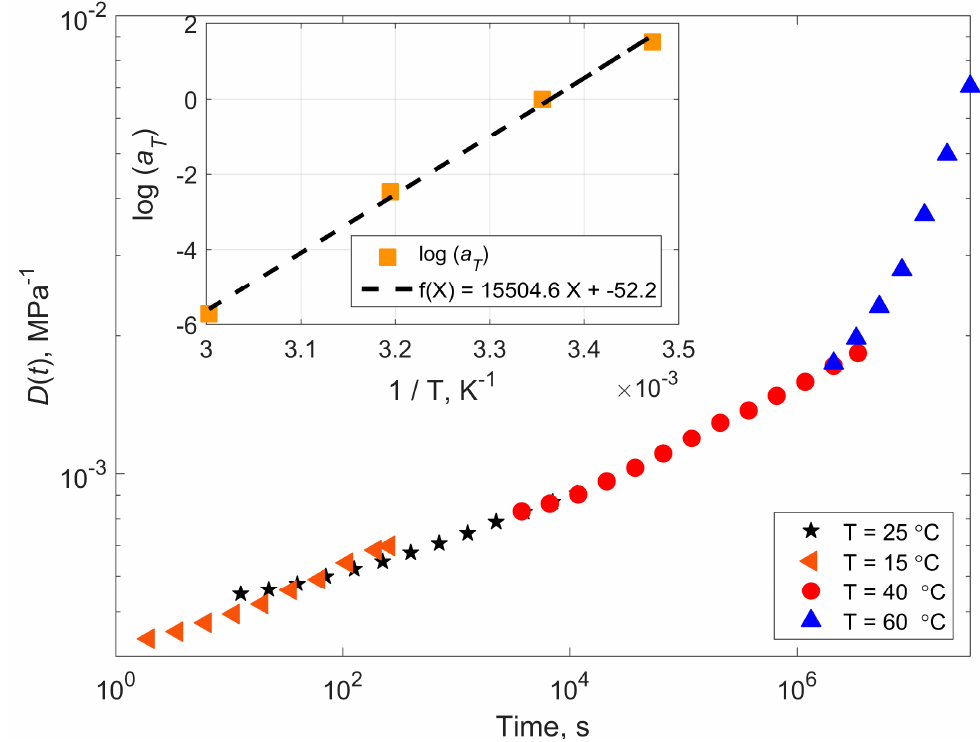
Figure 5. Creep compliance master curve of the saturated epoxy. σ = 10 MPa, T ref = 25 ° C. The inset shows variation of the shifting factor with inverse temperature and its linear fit with the corresponding equation. The activation energy calculated using Arrhenius equation is 297 kJ/mol.